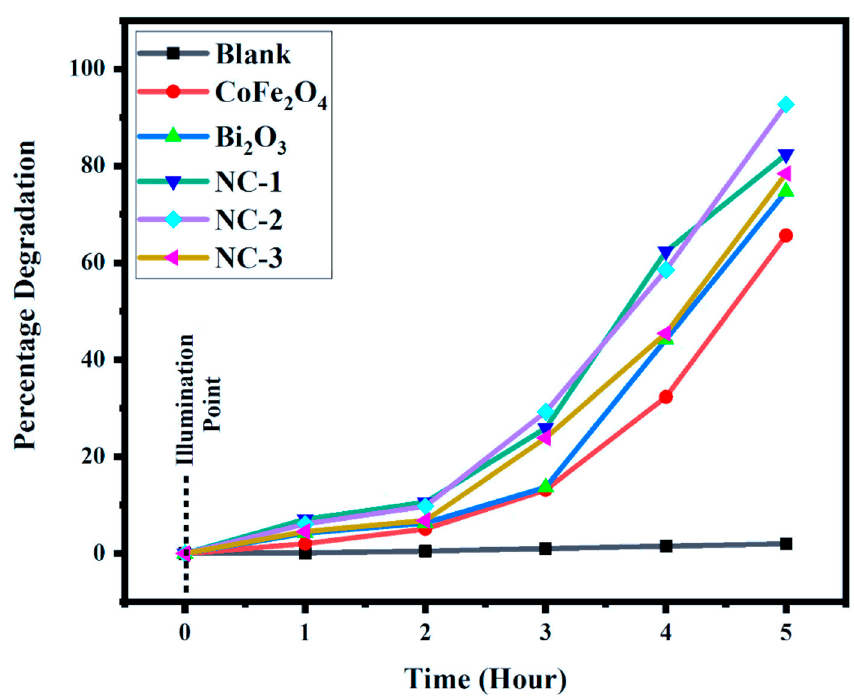
Figure 5. Photodegradation activities of as-prepared photocatalysts against methyl orange dye solution.